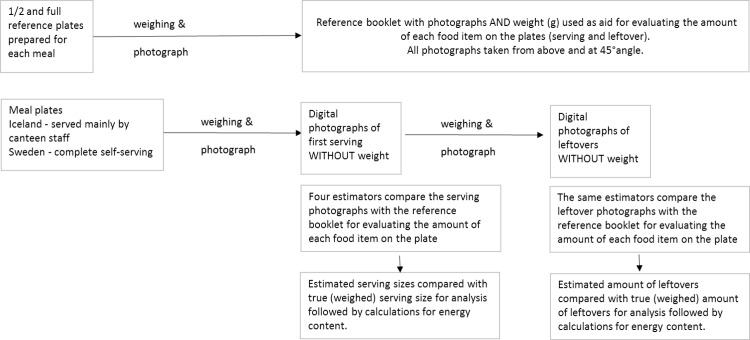
Study design–procedure in each country.